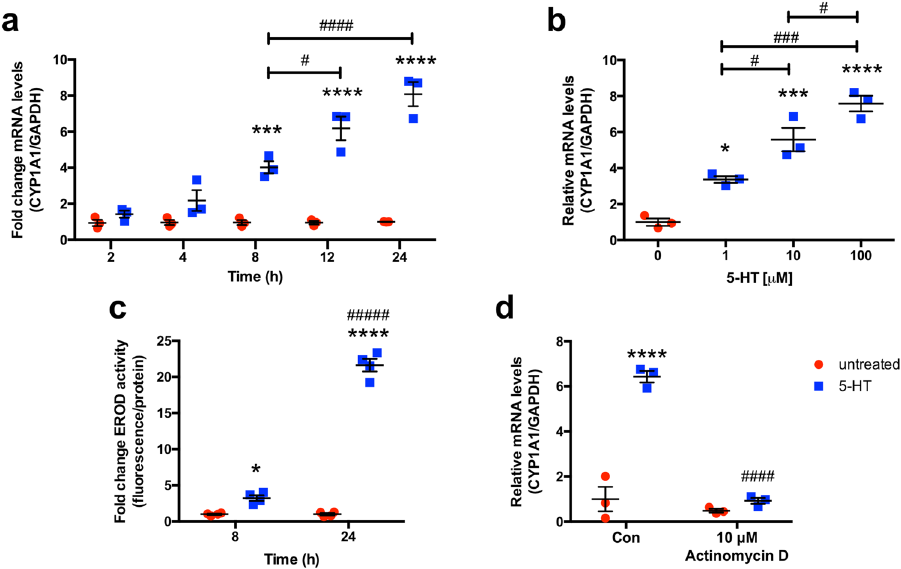
Figure 1. 5-HT induces CYP1A1 mRNA expression and activity via a transcriptional mechanism. Caco-2 cells were plated at low density and allowed to differentiate for 10–14 d in medium containing 20% serum before treatments were performed. ( a ) Caco-2 cells were treated with 5-HT in serum-free culture medium at a concentration of 10 μ M for 2 h–24 h ( n = 3) ( b ) or for 8 h at a concentration range of 1 μ M–100 μ M ( n = 3). Data represent the relative expression of CYP1A1 mRNA quantified by qPCR as compared to time-matched untreated cells. ( c ) Caco-2 cells were treated with 10 μ M 5-HT in serum-free culture medium and CYP1A1 activity was measured by the ethoxyresorufin-O-deethylase (EROD) assay ( n = 4). Assays were performed using triplicate wells for each treatment and values were normalized to total protein by Bradford assay. Results are expressed as fold-change over the activity of time-matched untreated cells. ( d ) Caco-2 cells were treated with vehicle (Con) or actinomycin D for 1 h before co-treatment with 5-HT for 24 h in serum-free culture medium ( n = 3). Data analyzed by 1-way ( a ) or 2-way ( b – d ) ANOVA followed by Tukey’s multiple comparisons test. * P < 0.05, *** P < 0.001, **** P < 0.0001 vs. no 5-HT. # P < 0.05, ### P < 0.001, #### P < 0.001 between groups. Red circle = untreated, blue square =